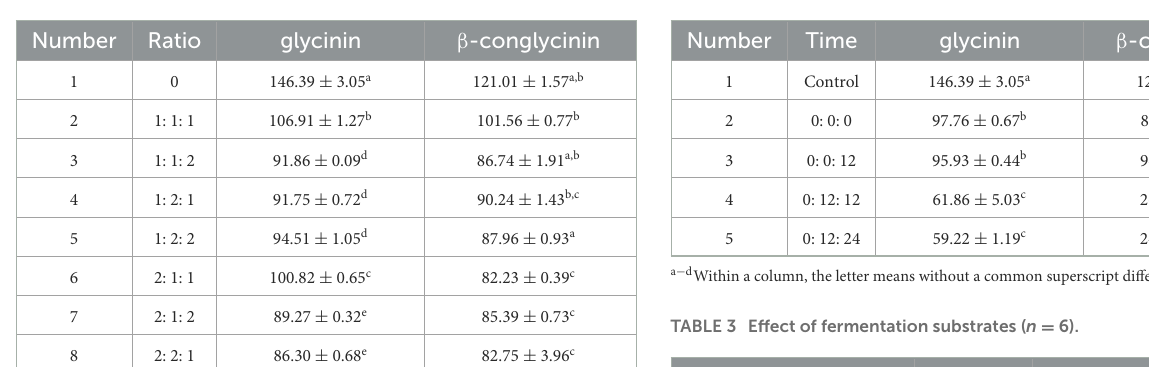
TABLE 1 Effect of the rate of inoculation on glycinin and β -conglycinin contents ( n = 6).